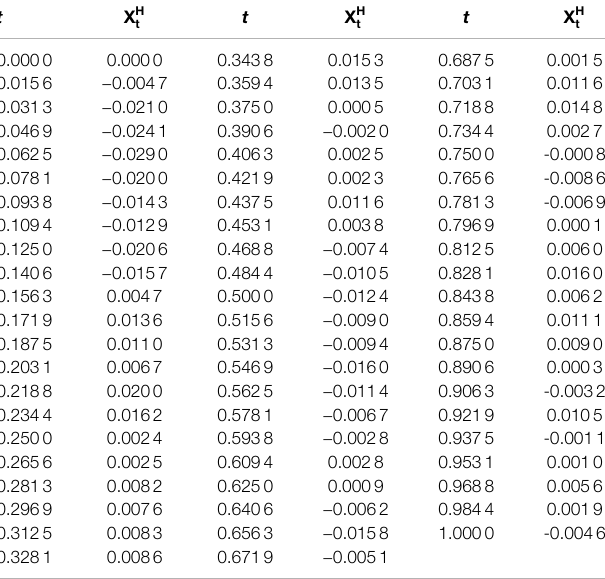
TABLE 1 | Data of X H t with θ (cid:1) 1 and H (cid:1) 0.7